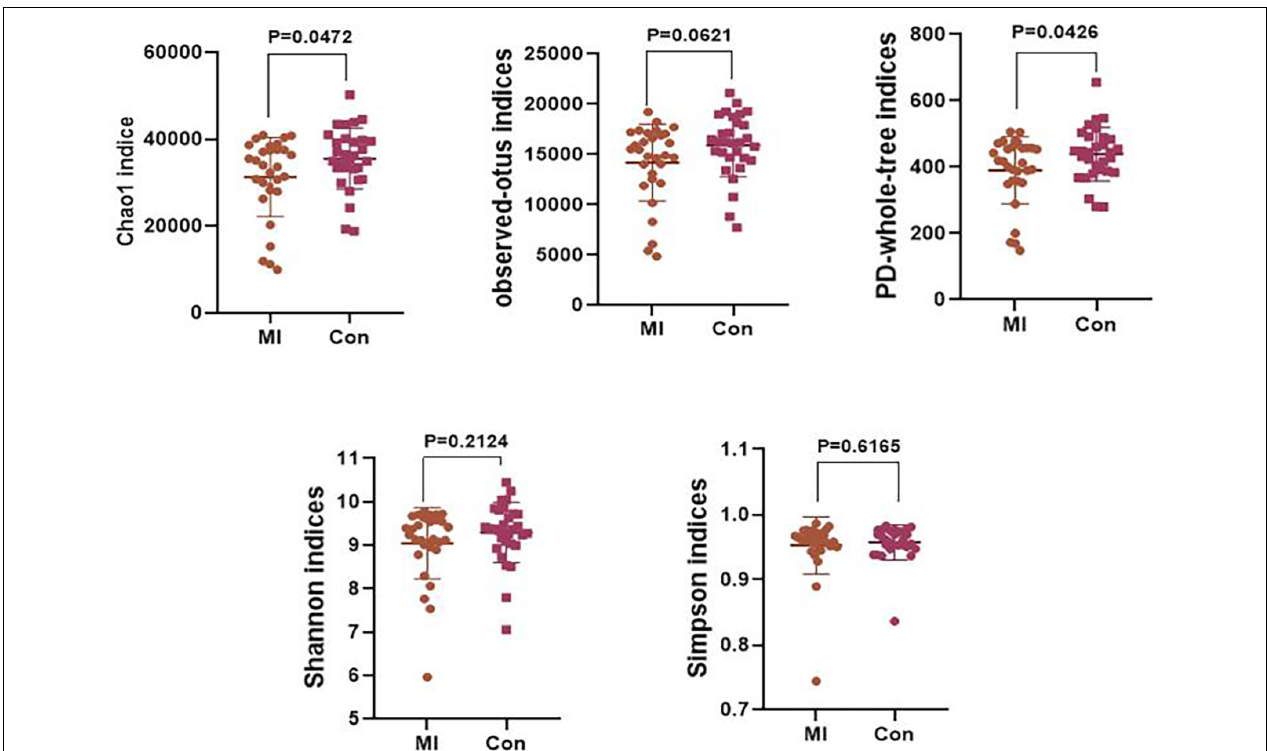
FIGURE 2 | The level of α -diversity indices of the gut microflora between the AMI group and the healthy control group. MI, AMI group; CON, the healthy control